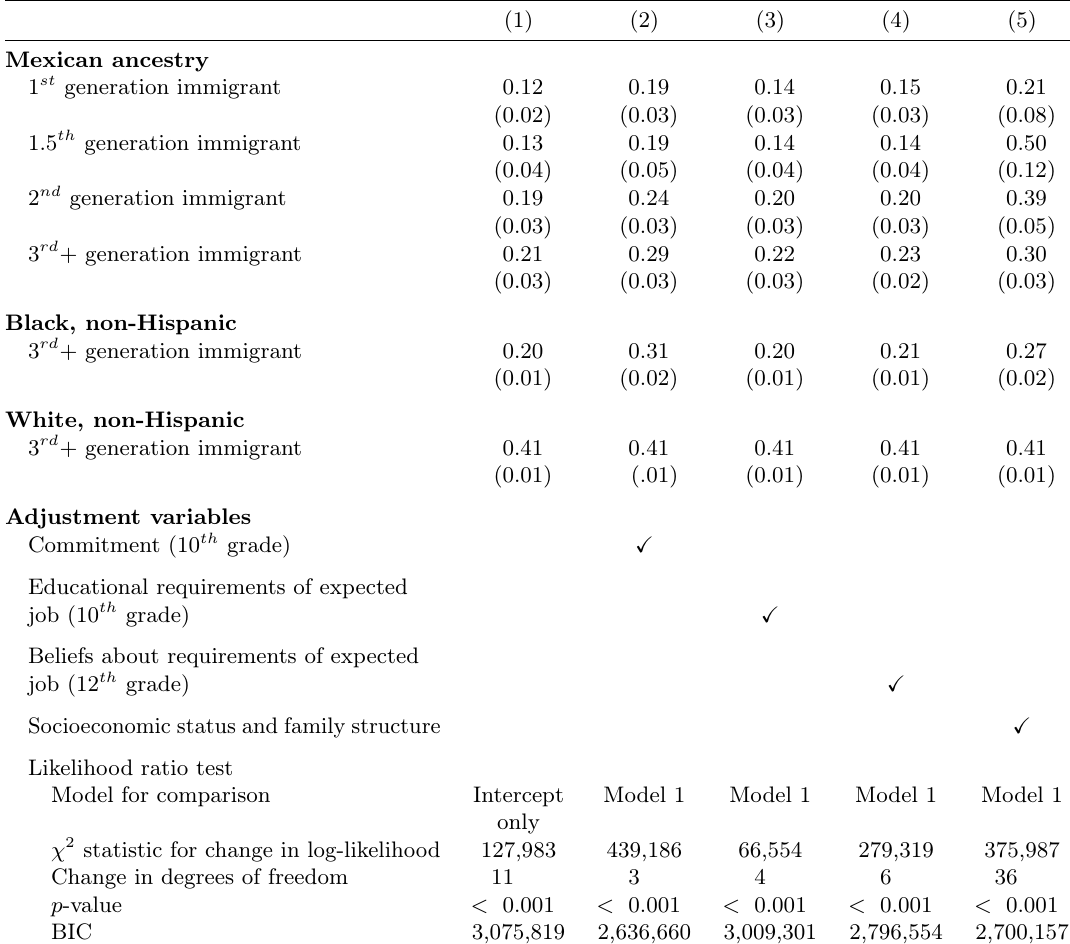
Table 5: Unadjusted and Adjusted Proportions of Students Enrolled in the 10 th Grade in 2002 Who Obtained a Bachelor’s Degree by 2012, Where the Adjustments Are Standardized to the Distributions that Characterize 3 rd + Generation Non-Hispanic